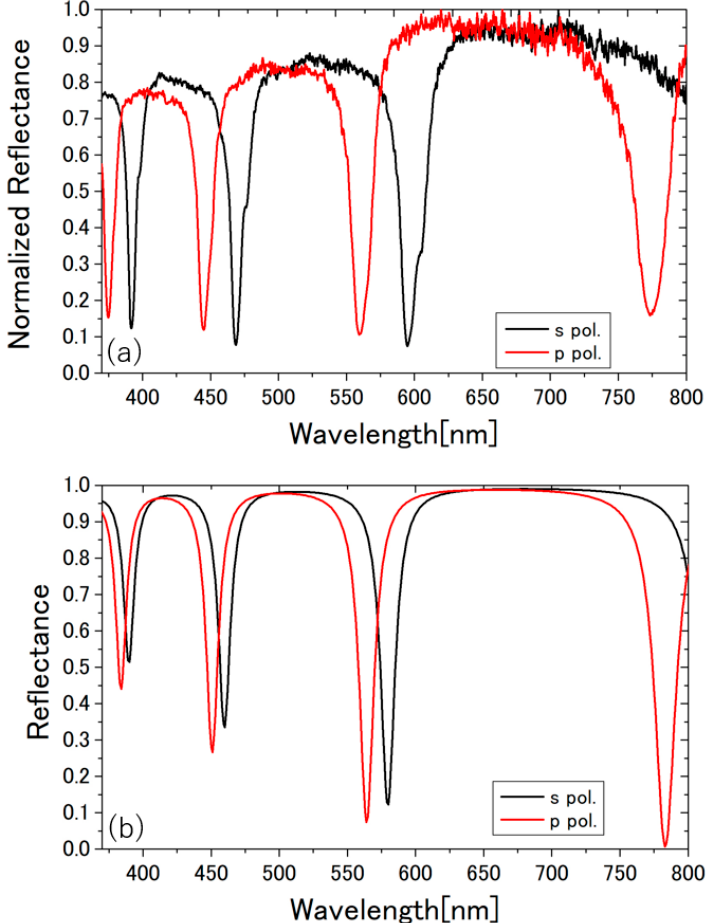
Figure 5. ( a ) Reflection spectra (p- and s-polarized) of the transparent PVP film on the transparent MgF 2 substrate at θ air = 88.5 ◦ incidence in air, obtained from the side-to-side transmitted light spectra at 88.5 ◦ incidence, divided by the baseline transmitted light spectra at 90 ◦ incidence (= normal incidence from the side, thus transmitted through the substrate without being reflected by the PVP film), and normalized to 1 at the maximum value. The depth of the deepest reflectance dip is 92.6% at 594.7 nm for s-polarization and 89.4% at 559.4 nm for p-polarization. The raw reflection spectra, before normalization, and the baseline spectra are shown in Appendix B. ( b ) Calculated reflection spectra at the incidence angle θ 0 = 88.92 ◦ from MgF 2 to PVP, which corresponds to the incidence angle θ air = 88.5 ◦ in air, with the thickness of the PVP layer assumed to be 1480 nm. The deepest reflectance dip has a 99.28% depth at 783 nm for p-polarization.